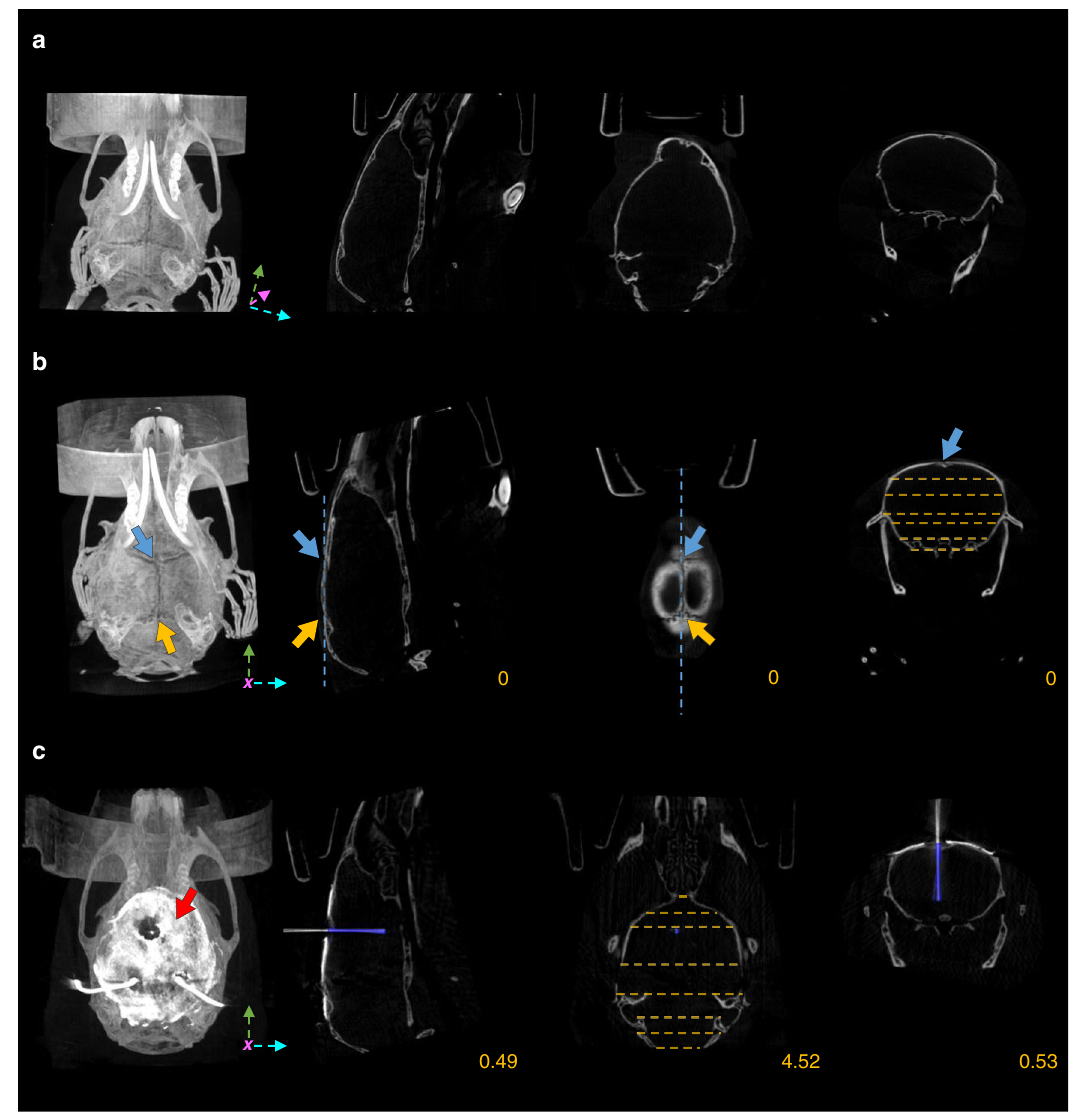
Fig. 2 CT-based implant localization. a Raw preoperative CT image. Canonical 3D axes used in brain atlas coordinate systems (green, pink, and cyan arrow) are not aligned with the coordinate system of the CT image. b The preoperative CT image was aligned to the atlas coordinate system by leveling the Bregma (blue arrows) with the Lambda (yellow arrows) in the sagittal plane (blue dashed lines) and symmetrical bone structures in the coronal and horizontal planes (yellow dashed lines). c After the implantation of an eight-tetrode microdrive, postoperative CT imaging was performed, and the scan was co-registered with the preoperative CT image. The skull was covered with a radiopaque dental adhesive (red arrow), which hid Bregma and Lambda. The implant was segmented (blue area) with an intensity threshold applied on a whole-brain region of interest (ROI). CT images are shown in grayscale. Images in each row from left to right, maximum intensity projection, sagittal slice, horizontal slice, and coronal slice. Yellow numbers refer to the corresponding mediolateral, dorsoventral, and anteroposterior stereotaxic coordinates in mm from